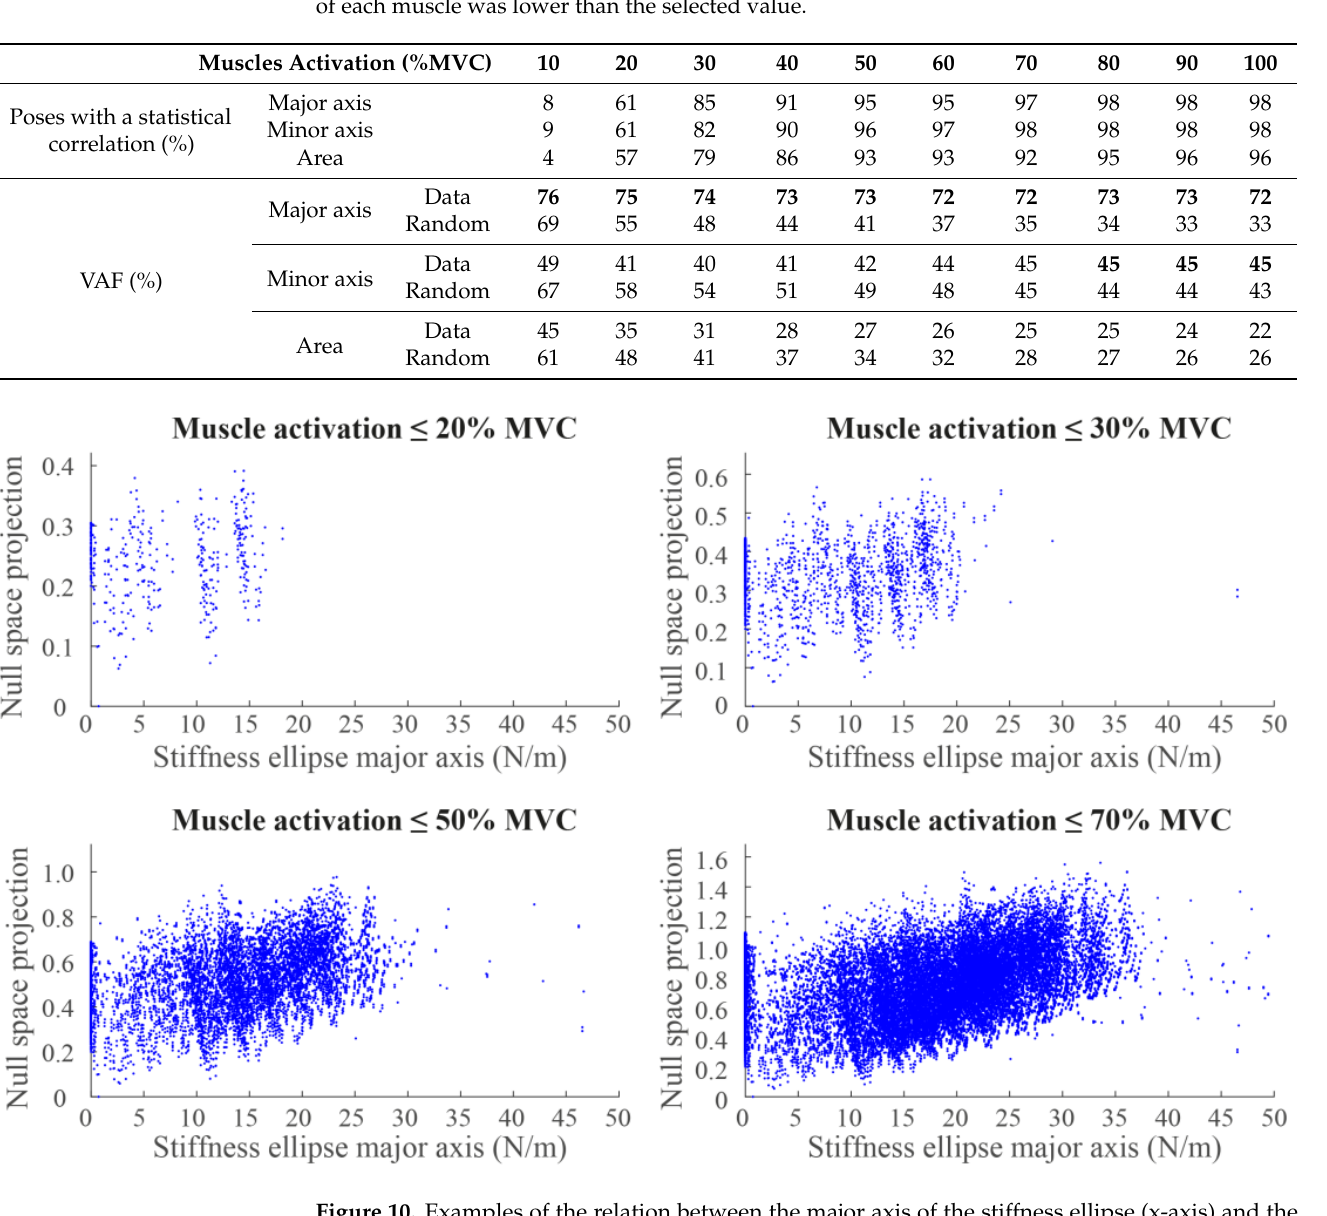
16 of 27 Table 1. Quality of the fitting of the major axis, the minor axis, or the area of the stiffness ellipse, as simulated with the musculoskeletal model, as the product of the null-space projection of the muscle activation normalized to the ratio between the mean null-space projection of the muscle activation divided by the mean value of the ellipse axes or area. The top rows show the percentage of the musculoskeletal model poses, showing a significant ( p < 0.05) regression between the stiffness ellipse axes or area and the norm of the null-space projection. The bottom rows show the VAF of the ap- proximation of the stiffness ellipse axes or area as the product of the null-space projection of the muscle activation ( “ Data ” ) and as the 95% percentile, over 500 repetitions, of the product of the null-